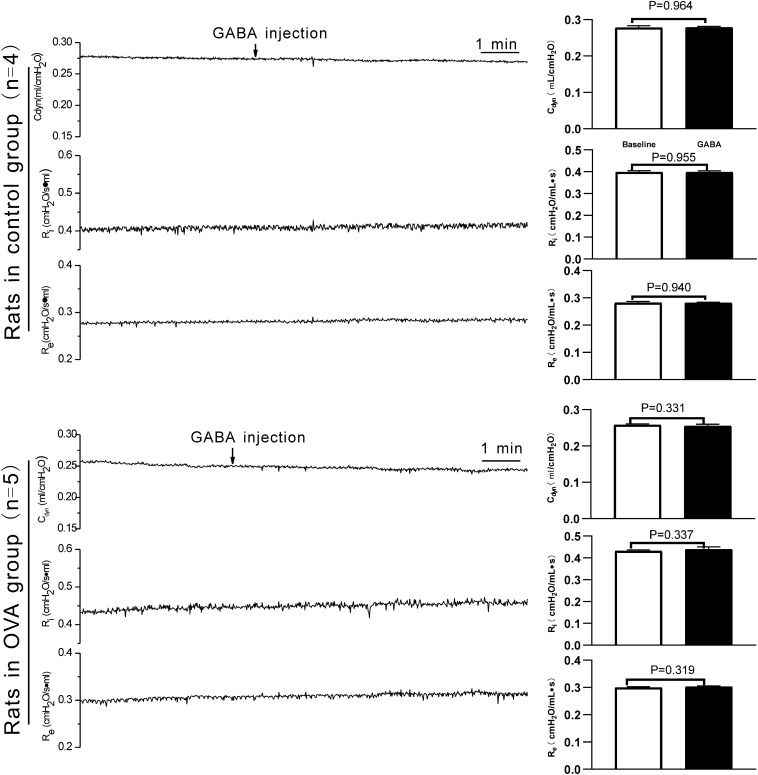
Pretreatment with atropine abolished the pulmonary responses to intracisternal injection of GABA solution, both in rats of control group and in rats of OVA group. 20 min after subcutaneous injection of atropine sulfate (0.5 mg/kg), intracisternal injection of GABA solution (50 μmol/L, 50 μL, in a 20-s period) did not cause any significant change in Cdyn, Ri and Re, either in rats of control group (upper part) or in rats of OVA group (lower part). Raw recordings from representative experiments are shown on the left side; and summarized data are shown as bar graphs on the right side. P-values were obtained from paired t-test.